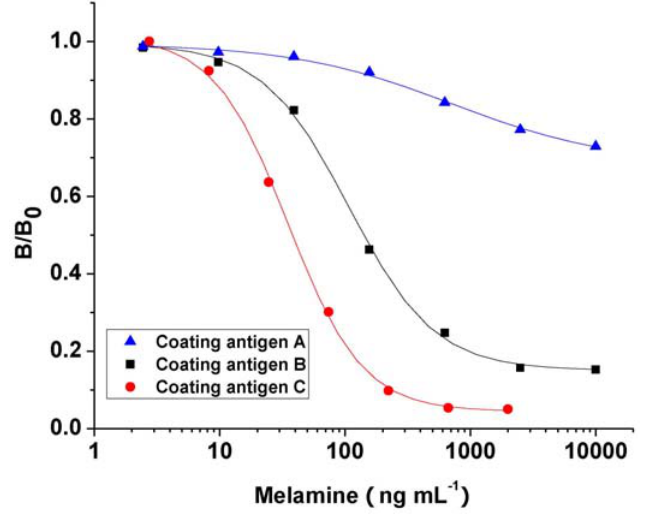
Figure 4. Typical calibration curves for melamine based on different coating antigen.